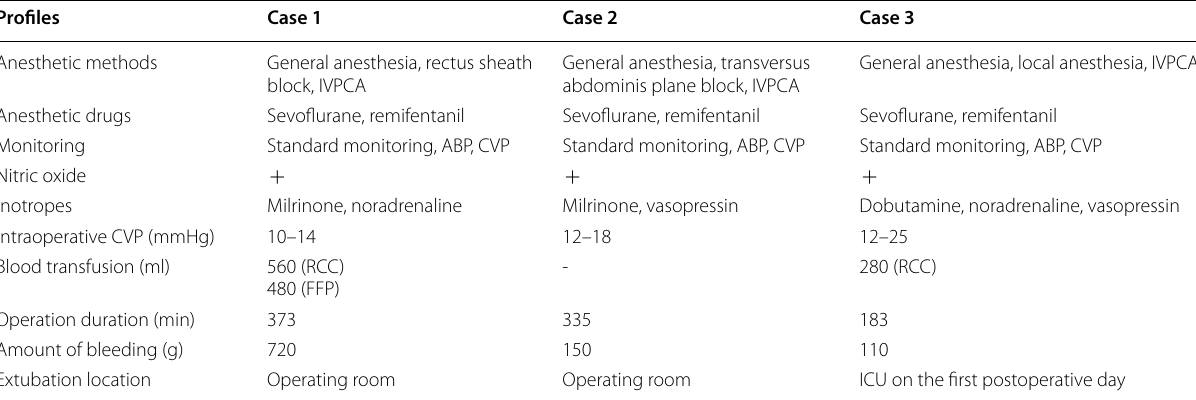
Table 2 Intraoperative profiles of the three